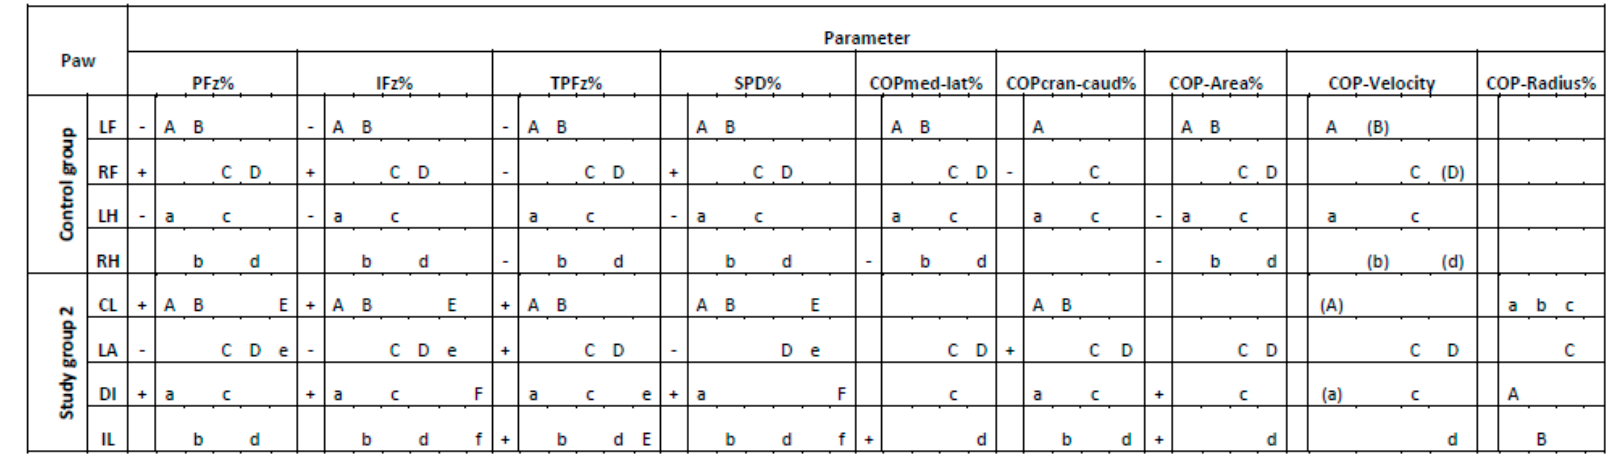
Table A4. Overview of the significant di ff erences in the parameters of study group 2 and control group.